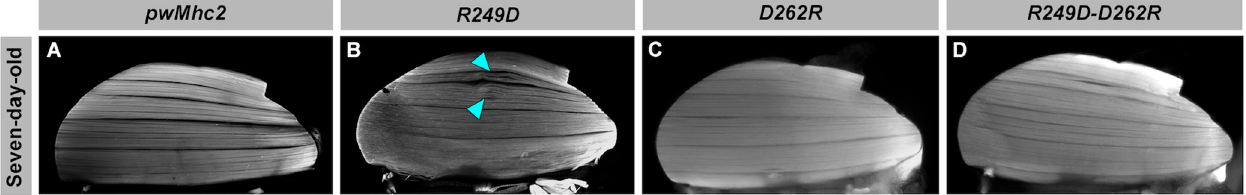
Figure 2. Normal gross level structure of dorsolongitudinal IFM fibers of R249D , D262R and R249D- D262R mutant adults. Bisected thoraces were stained with phalloidin and imaged via fluorescence microscopy. Shown are seven-day-old adults with the following genotypes: ( A ) pwMhc2 wild-type control, ( B ) R249D , ( C ) D262R , ( D ) R249D - D262R double mutant. Fibers are of generally normal shape and size in all genotypes, indicating that there are no gross level defects, such as hypercon- traction. However, R249D fibers show gaps (cyan arrowheads).